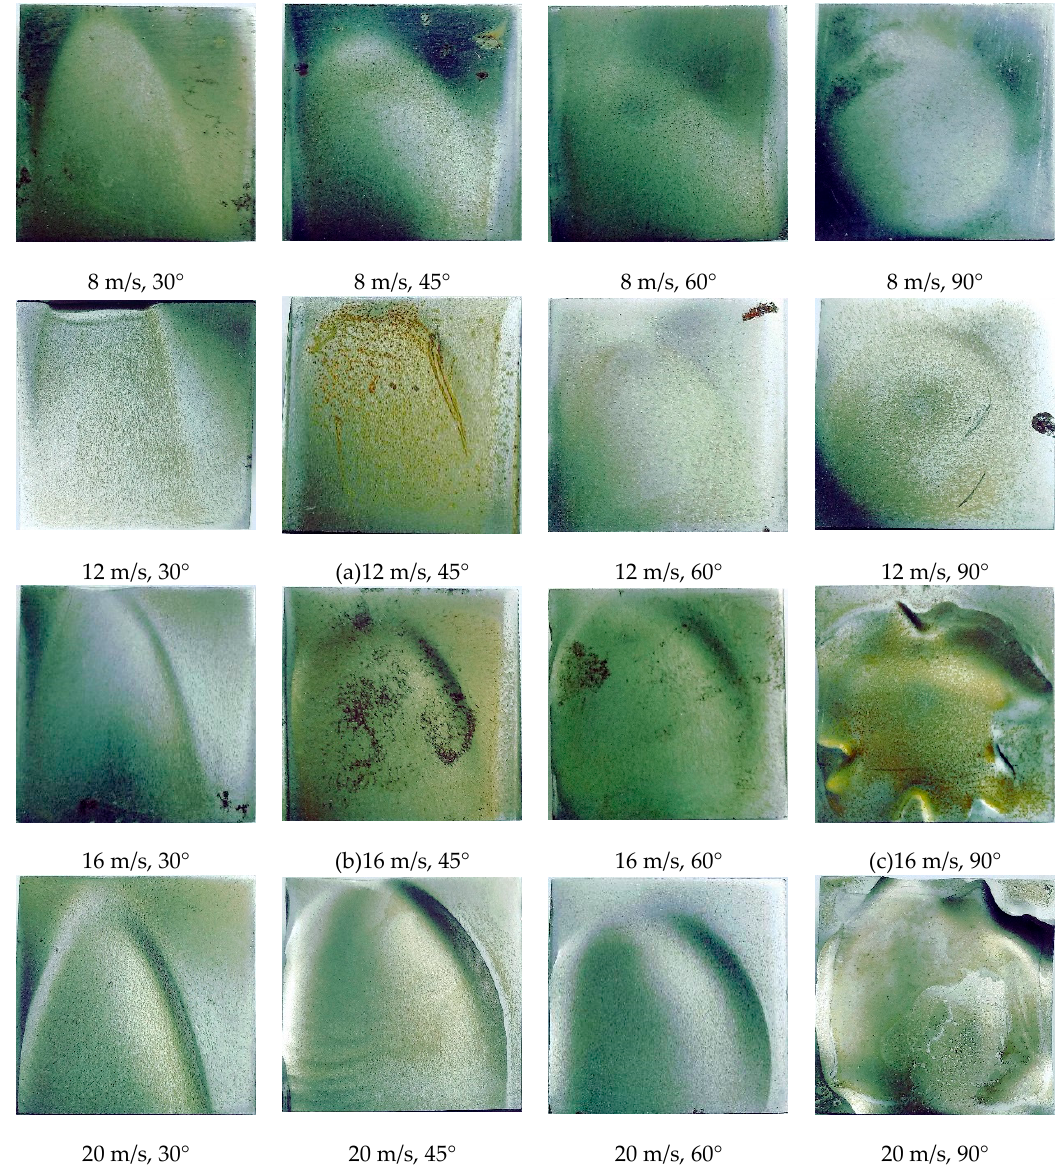
Figure 11. Surface images of 13Cr after erosion and corrosion in liquid–solid two-phase flow. By immersing the erosion surface in flowing liquid for 1 h of corrosion, the surface morphology of 3Cr and TP140 under corrosion and non-corrosion is obtained as shown in Figure 12. The erosion surface of TP140 after corrosion shows that the lip is broken down and changed into platelets (Figure 12b). This is because the corrosion of carbon steel exists in the surface of lips and in the crack, and crevice corrosion reduces the thickness of the root of lips, thereby making the material easier to peel off. At this time, the material is continuously and uniformly peeled off from the surface as the liquid shearing force acts. As for the erosion surface of 13Cr, corrosion does not occur on all surfaces due to the presence of a passivation film instead of the local pits (Figure 12d). Although these pits are not as severe as the uniform corrosion for the matrix, they do not damage the passivation film for the stainless steel. In addition, with the expansion of pitting pits, the erosion resistance of the materials is seriously weakened, especially for the impacts of large particle in high